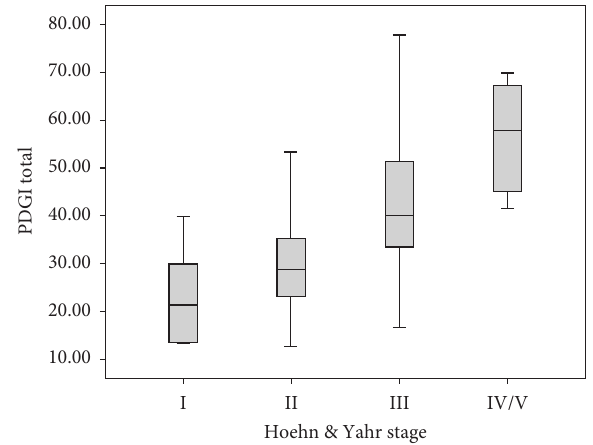
Figure 1: Boxplot of the PDGI total for the H&Y